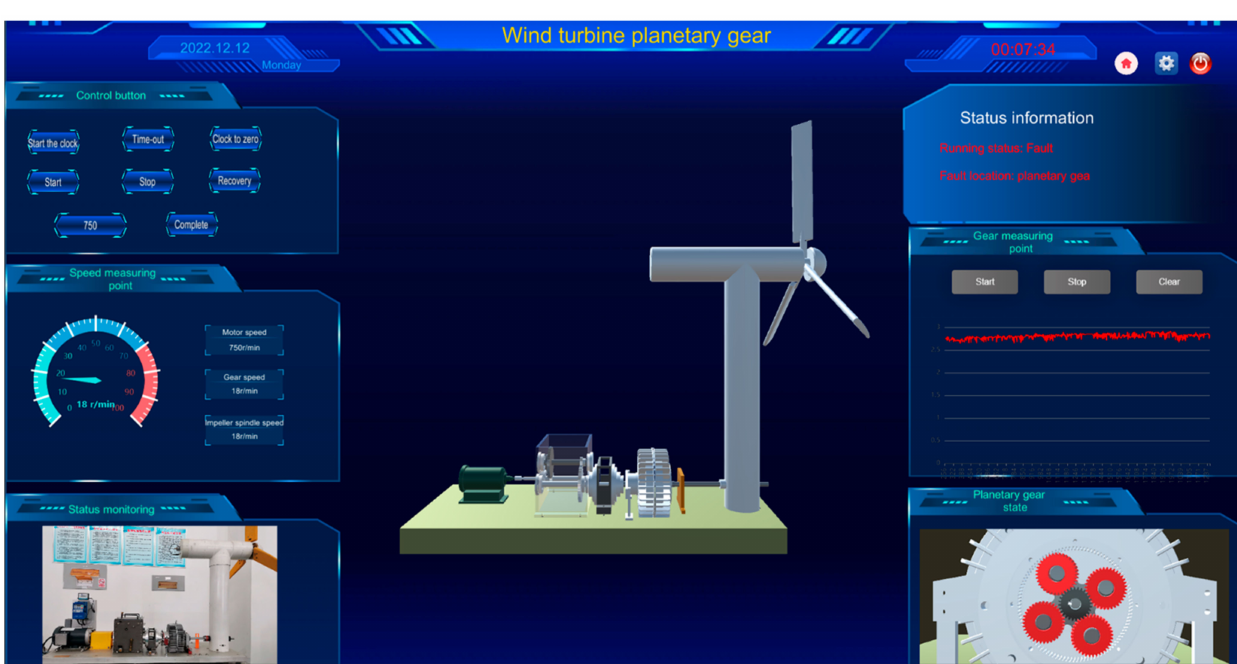
Figure 15. Fault diagnosis effect